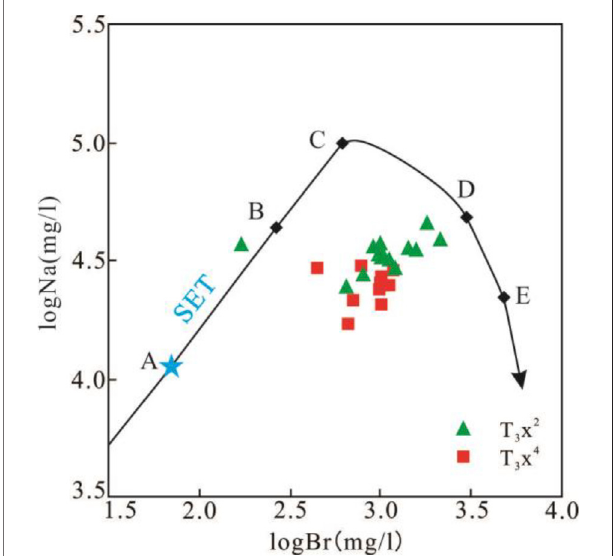
FIGURE 4 | Relationship between the logBr-logCl and SET of the formation water of the Xujiahe Formation in the middle part of the western Sichuan Depression. Notes: SET and the positions of points A, B, C, D, and E refertoCarpenter(1978).SETistheseawaterevaporationcurve.PointA represents normal seawater, point B represents the beginning of precipitation ofgypsum, point Crepresentsthebeginning ofprecipitation ofsaltrock,point D represents the beginning of precipitation of magnesium sulfate, and point E represents the beginning of precipitation of potassium salt.